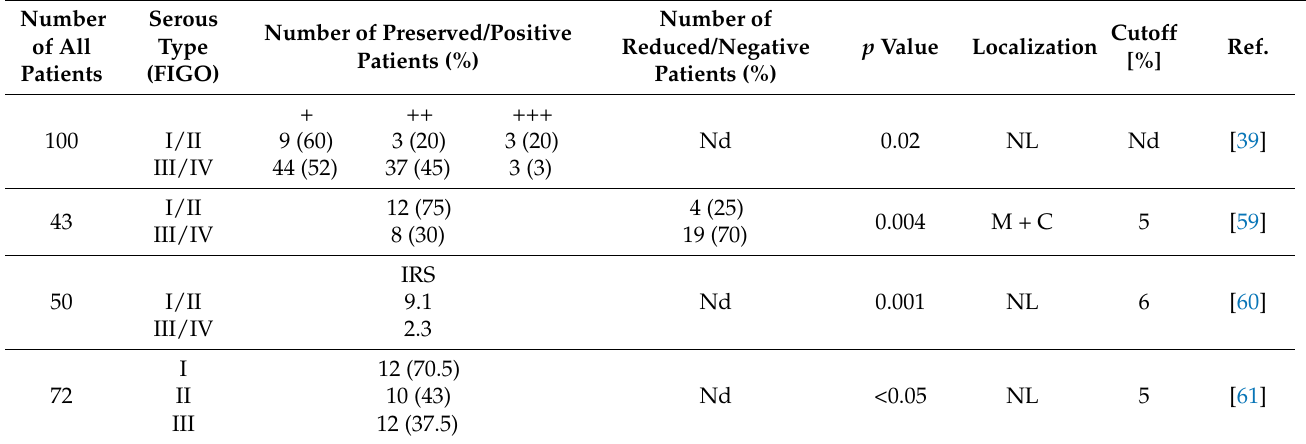
Table 3. The association of E-cadherin expression with FIGO of serous ovarian cancer